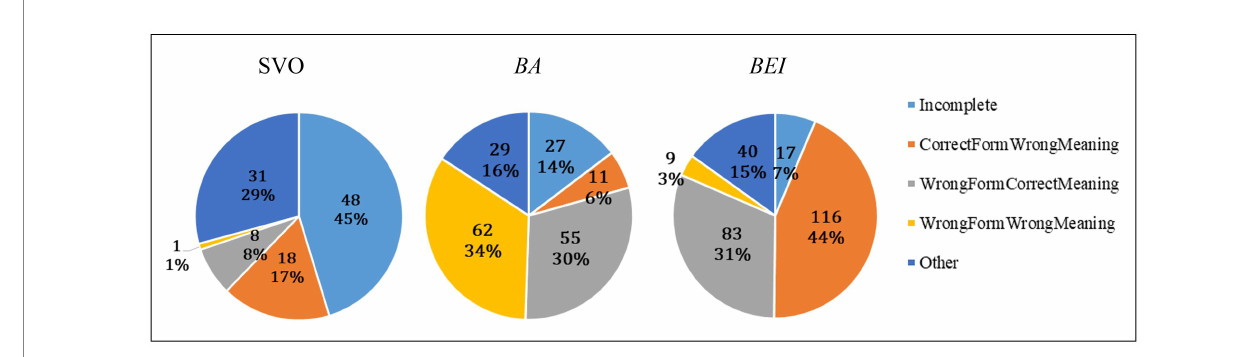
FIGURE 6 The distribution of different errors across the three sentence